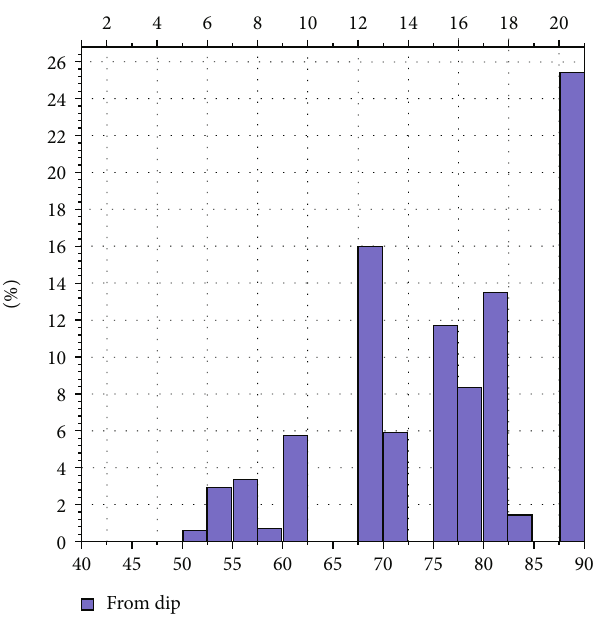
Figure 4: Histogram of fault dip distribution.